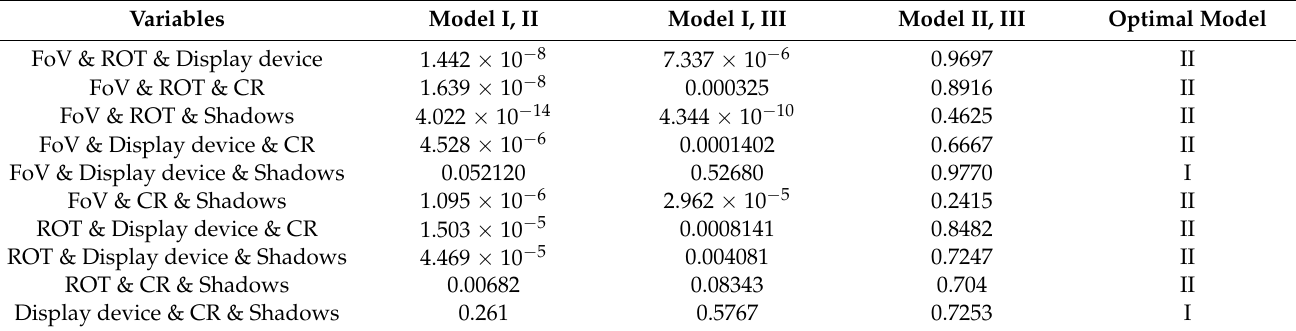
Table 4. Comparison of models ( p